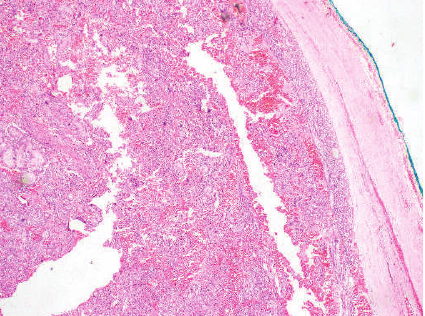
Figure 7: Haematoxylin and eosin stained section showing thin fibrous capsule encircling the tumour ( × 200).